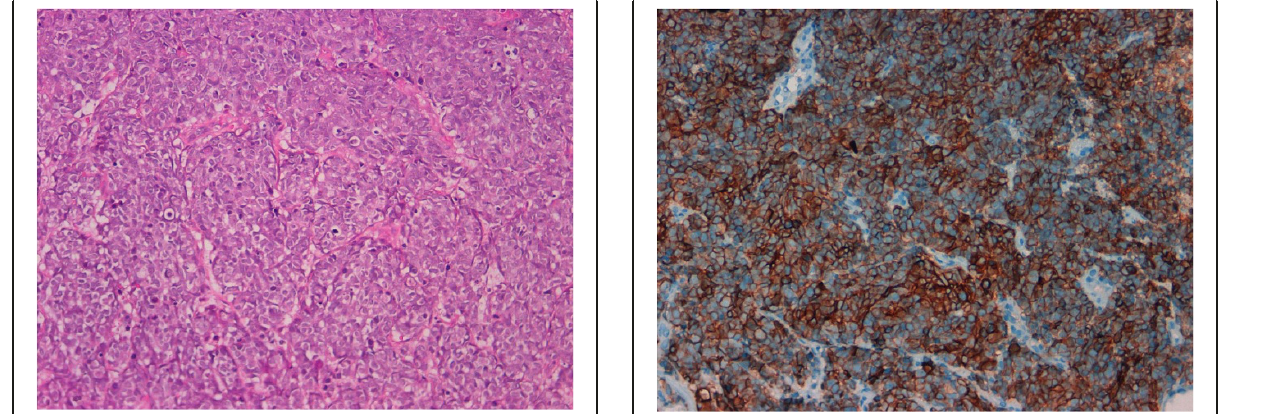
Figure 1 Neoplastic cells showing a sheet-like growth with trabecular and rosette-like patterns (H&E 20x).